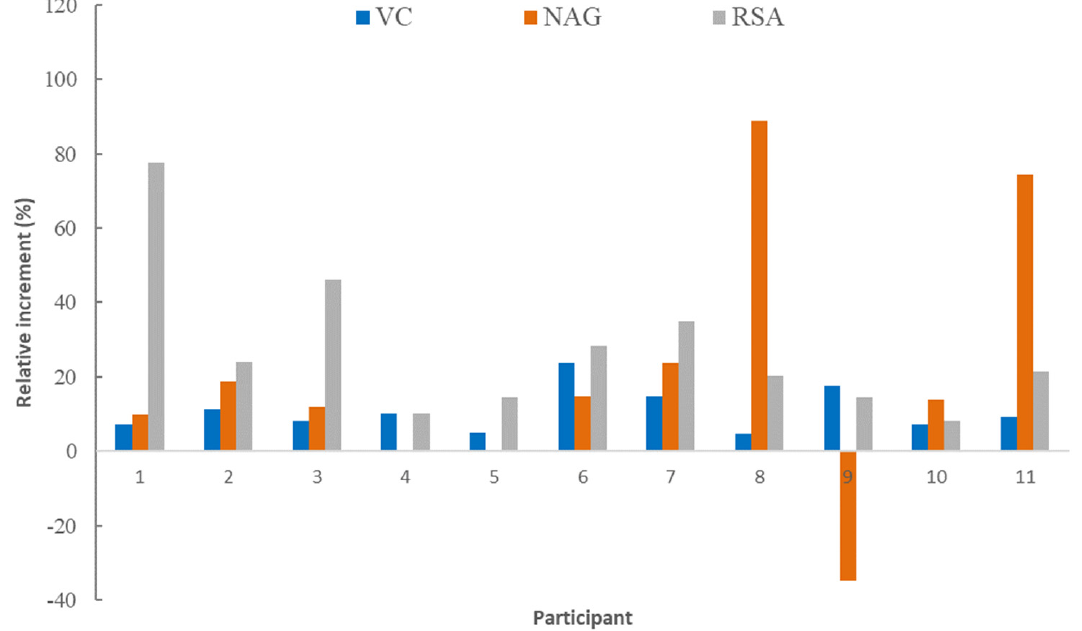
Figure 2. Relative increase, related to fasting level, in serum blood vitamin C (VC), naringenin (NAG), and radical scavenging ability (RSA) due to reconstituted freeze-dried juice intake by each participant.